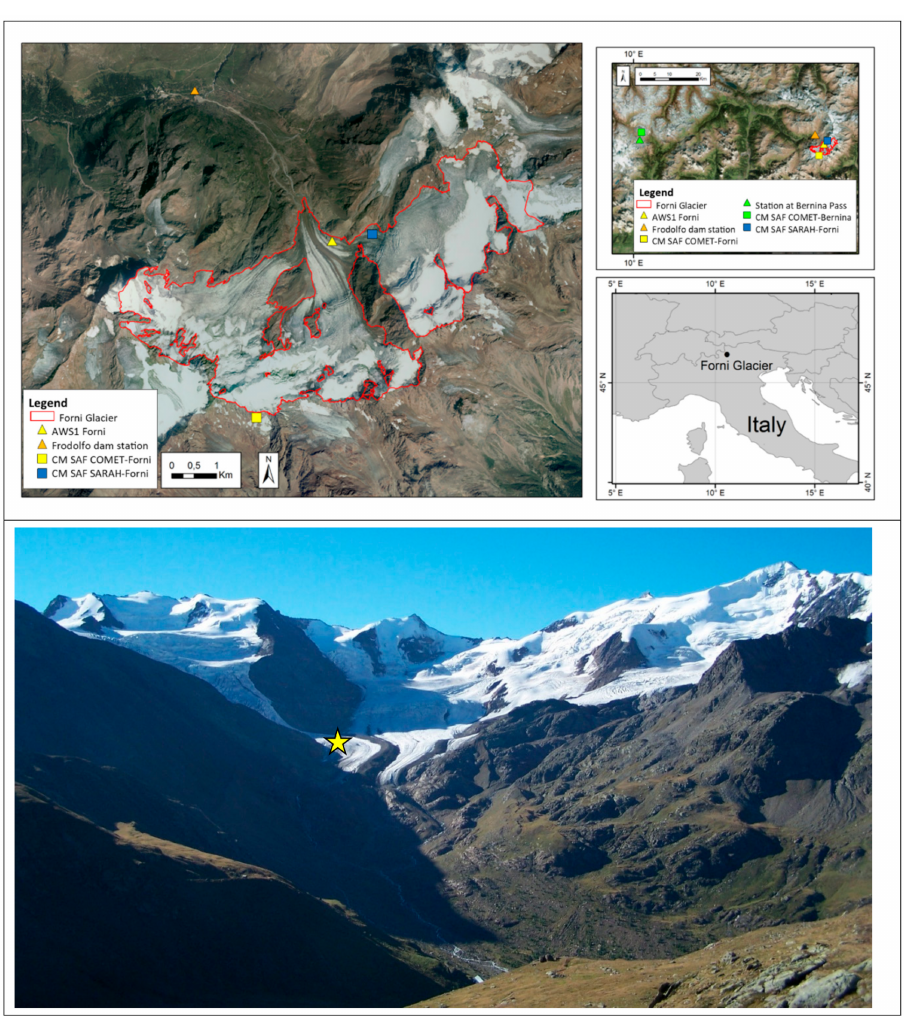
Figure 1. The Forni Glacier study area (the glacier boundary is marked by the red line). The main panel in the upper part of the figure shows the locations of AWS1 Forni (yellow triangle), Frodolfo dam station (orange triangle), and the center of CM SAF COMET and CM SAF SARAH grid-cells relative to AWS Forni site (yellow and blue squares, respectively); the upper right panel also shows the Bernina Pass station (green triangle) and the center of the corresponding CM SAF COMET grid-cell (green square). The lower part of the figure shows the study area (yellow star indicates AWS1 Forni) as it is observed from the Rifugio Branca during summer